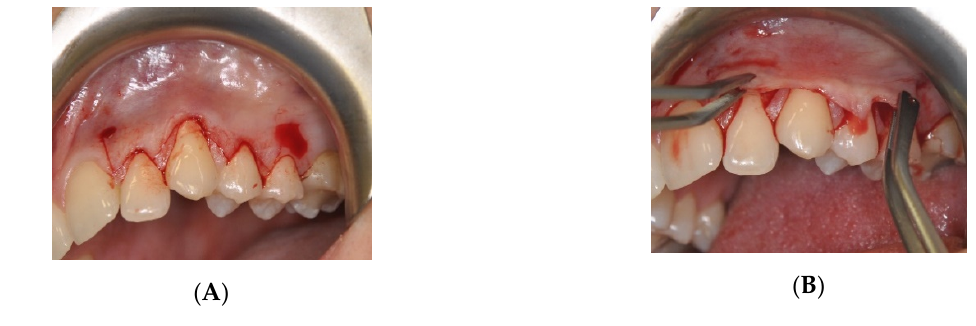
Figure 3. Flap design: ( A ) intrasulcular incisions join in the interdental space oblique incisions; two vertical releasing incisions, mesially and distally to the gingival recession defect; ( B ) flap is raised with a split-thickness approach. Medially and distally to the operating field, vertical releasing incisions were per- formed to obtain a trapezoidal flap shape (Figure 4). After the creation of surgical papillae, the coronal parts of the anatomical papillae were deepithelialized (Figure 5).